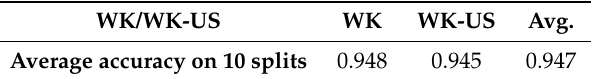
Figure 21. Lowest and highest accuracy confusion matrices for the VGG16-LSTM network corresponding to each group: ( a , b ) the WK/WK-US group; ( c , d ) the “SD/ST/CY group. Table 13. Average F 1 accuracy of the WK/WK-US group.